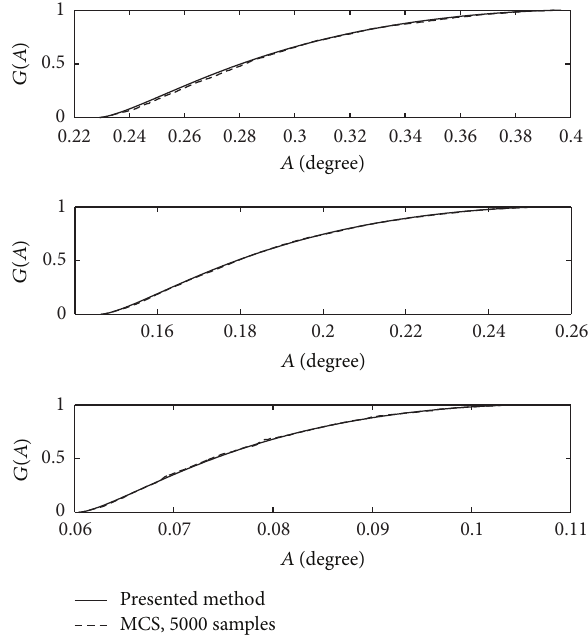
Figure4:Thedistributionfunctionsforthethreeextremesof 𝐴 with = 2.5 , 𝛿 = 100 , and 𝛿 = 50 . 𝑈/𝑈 𝑓 0 1